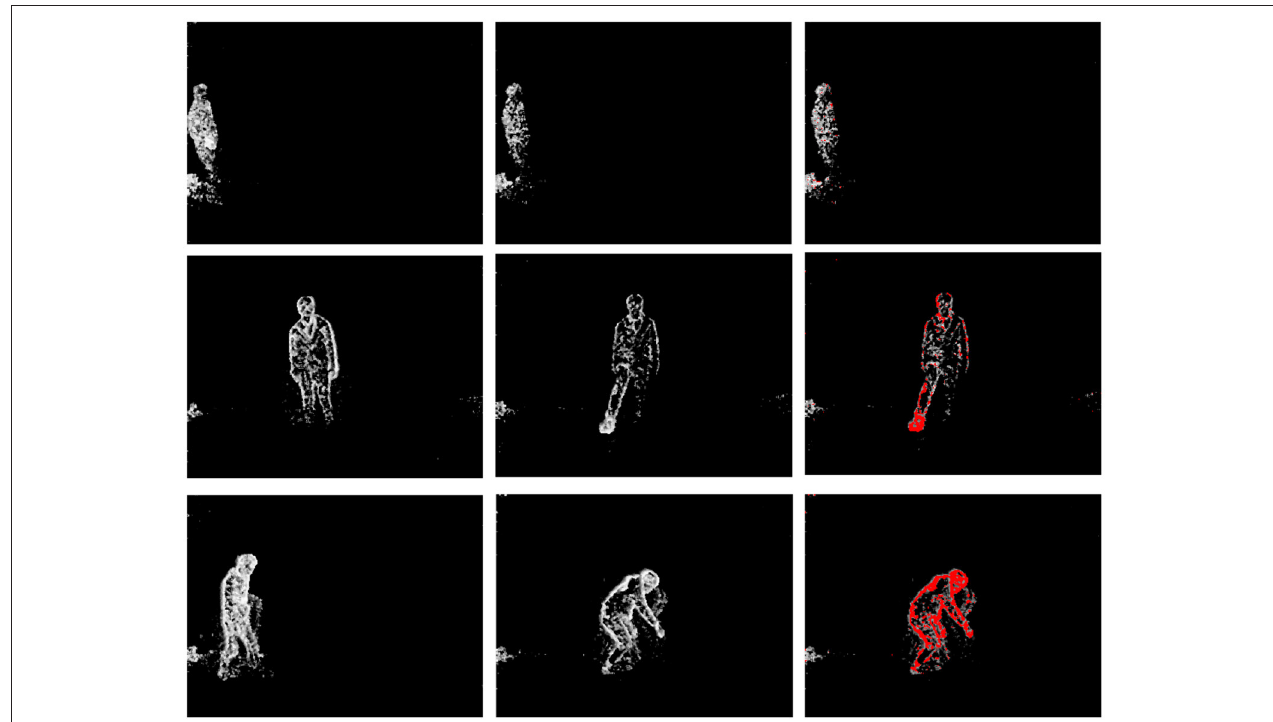
FIGURE 5 | Top : Walking (normal) activity, Middle : Kicking (anomalous) activity, Bottom : Picking (anomalous) activity. Visualization of original events (left and middle) en t ) overlaid as red over the original events if it exceeds a pre-defined threshold at times t − 1 and t and the difference between original ( en t ) and predicted events ( en t ) | ≥ Threshold → red ). It could be seen that the difference between original and predicted events (red color) is prominent in the case of (right) ( | en t − ( b b